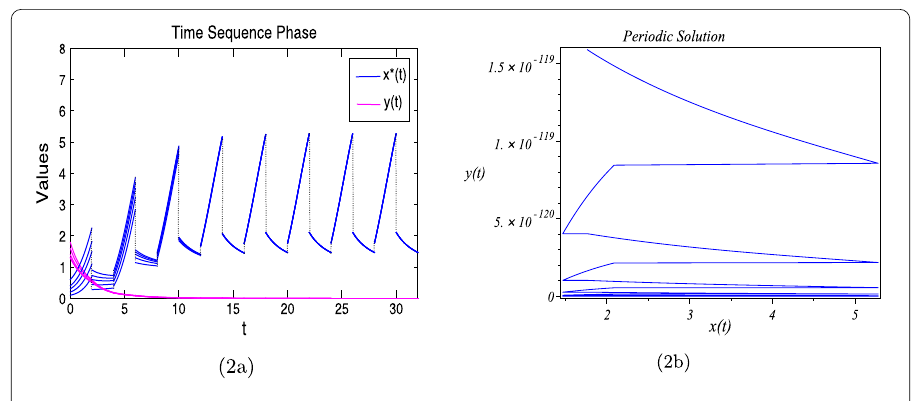
Case 4, if δ 1 ≥ 0 (or δ 1 ≤ 0), δ 2 ≤ 0 (or δ 2 ≥ 0) and δ = δ 1 + δ 2 ≤ 0, then the conclusion